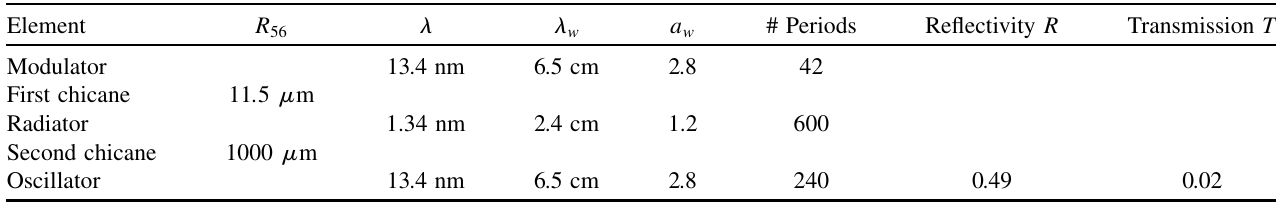
TABLE II. Some key parameters for the beam line elements.